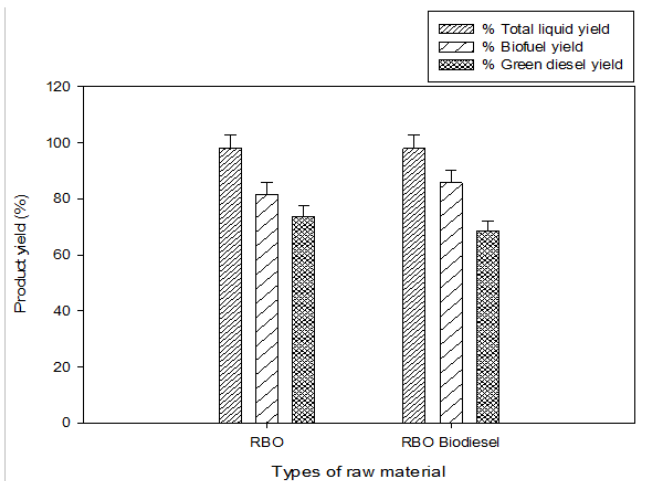
Figure 9. Percentage crude biofuel yield, percentage refined biofuel yield and percentage BHD yields on the effect of raw material types.